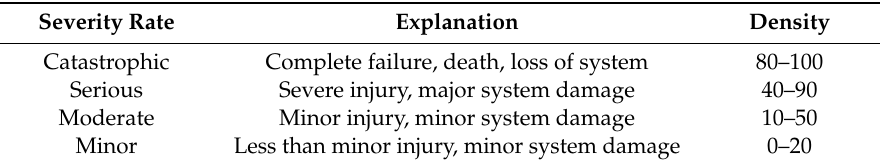
Table 4. The severity categories for the hazard